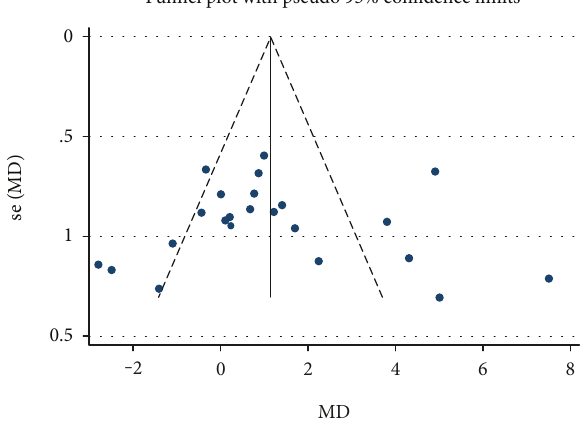
Figure 4: Funnel plot and assessment of publication bias. Funnel plot with 95% pseudocon fi dence intervals of the e ff ect size and its standard error for studies assessing the e ff ects of newer antidiabetic drugs on the primary endpoint endothelial function. Large studies appear toward the top of the graph and tend to cluster near the mean e ff ect size. Smaller studies appear toward the bottom of the graph and (since there is more sampling variation in e ff ect size estimates in the smaller studies) will be dispersed across a range of values. The symmetric distribution of studies about the combined e ff ect size indicates the absence of publication